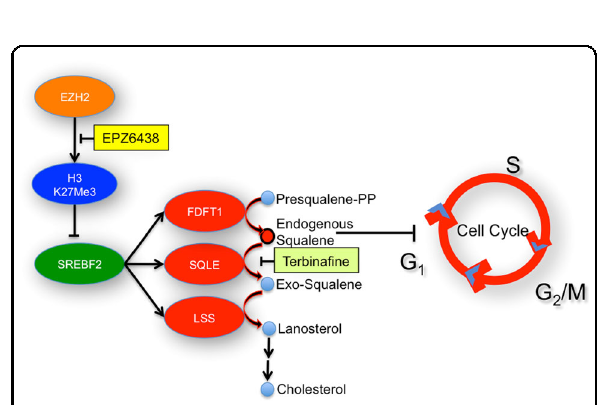
Fig. 7 Simultaneously targeting of EZH2 and SQLE signi fi cantly inhibits the tumour growth of HNSCC. A schematic illustration of the proposed model in which EZH2 inhibition sensitizes SQLE inhibitors to inhibit HNSCC